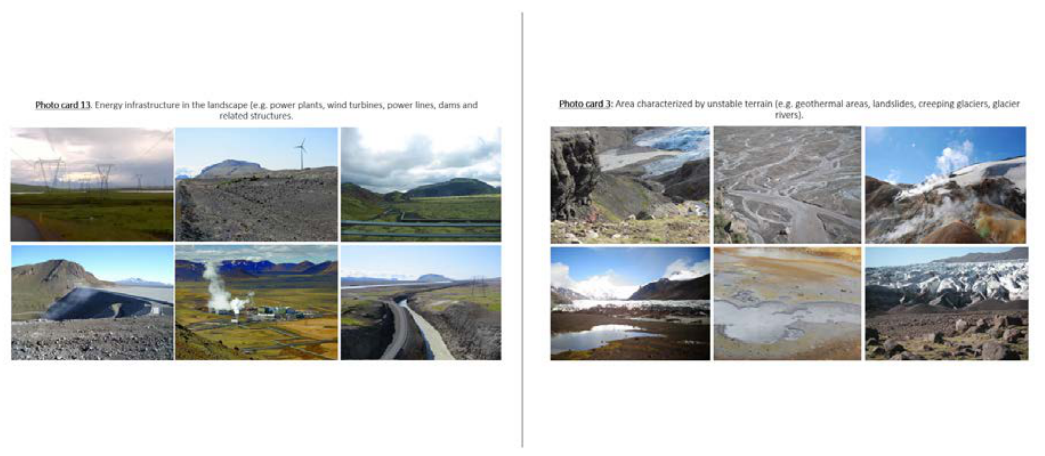
Figure 7. Two examples of photo cards and statements used to describe the 26 landscape scenarios used in the questionnaire survey.